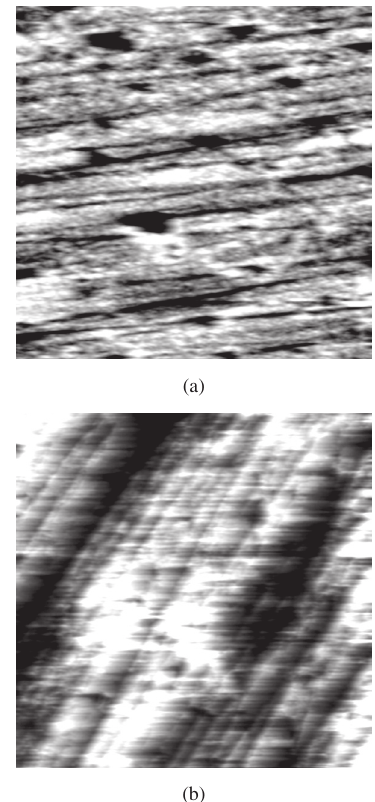
Figure 3. AFM topographic images corresponding to scan areas of (20 x 20) µm 2 . a) pure Ti, Z = 160 nm; and b) LYZ adsorbed onto Ti, Z = 70 nm.